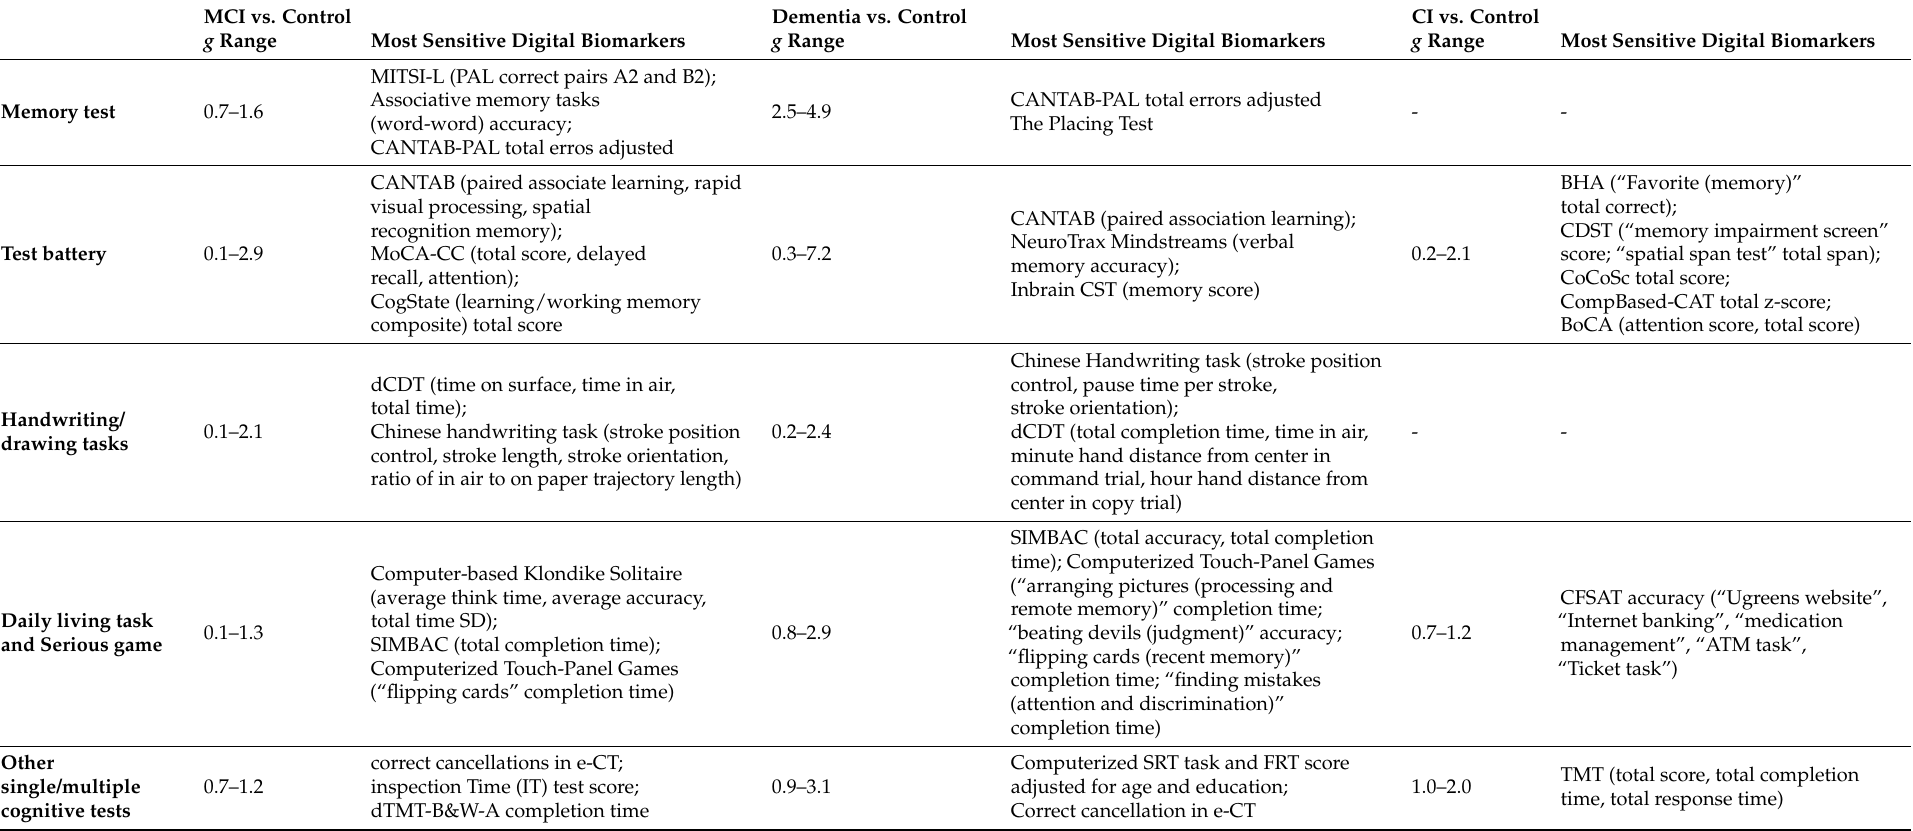
Table 1. Summary on the effect sizes of groups difference in various outcomes of computerized